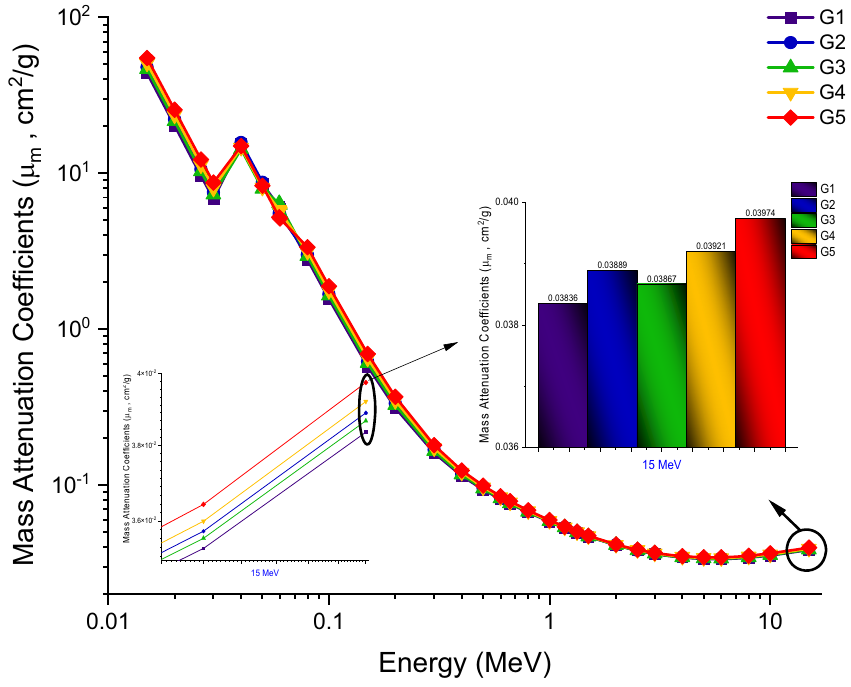
Figure 4: Variation of mass attenuation coe ffi cients ( cm 2 /g ) with photon energy ( MeV ) for all G1 – G5